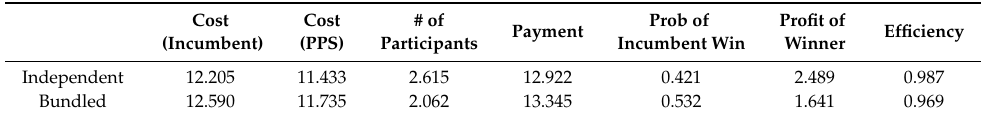
Table 5. Expected values for independent vs. bundled auctions (case